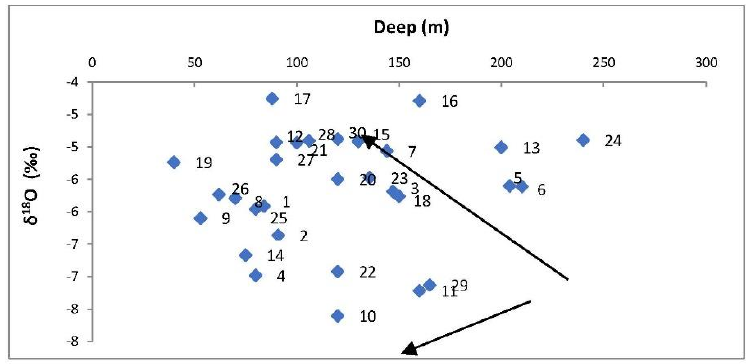
Figure 14. δ 18 O versus the depth of the boreholes.